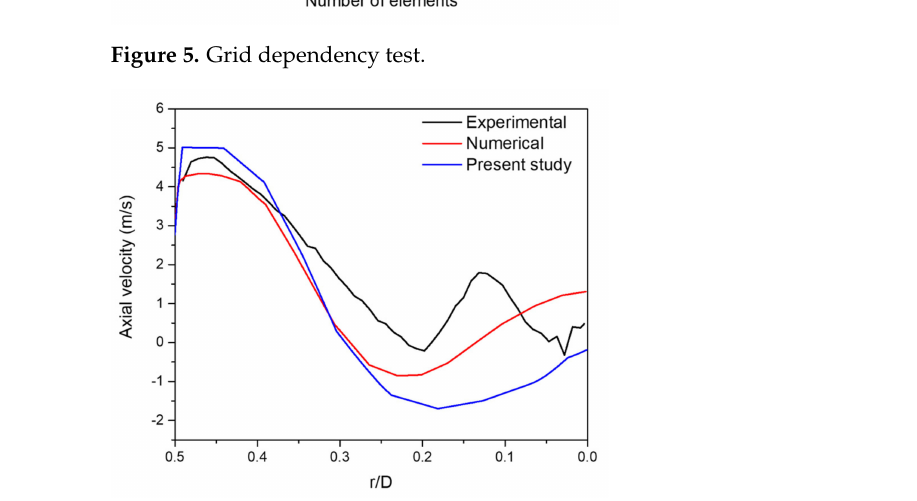
Figure 6. Comparison of the present study and literature data of numerical and experimental results